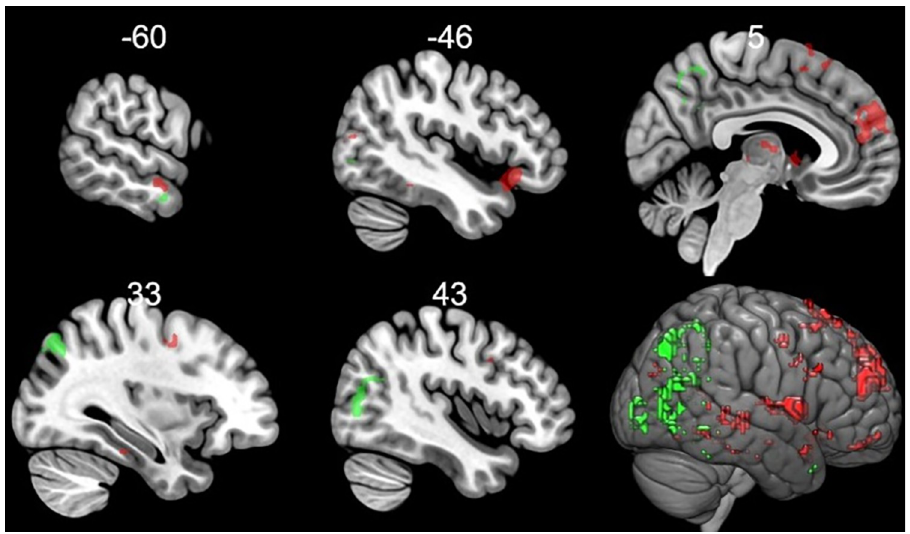
Fig 6. Activated regions when the context categorically changed the valence of the emotional stimuli (from negative to positive and from positive to negative) after excluding the general effect of context. Increased activations when a negative stimulus was put in a positive context are shown in green whereas increased activations when a positive stimulus was put in a negative context are shown in red. Coordinates are in the Montreal Neurological Institute (MNI) space. Statistical maps were visualized on the MNI 152 template brain provided in MRIcroGL [39].